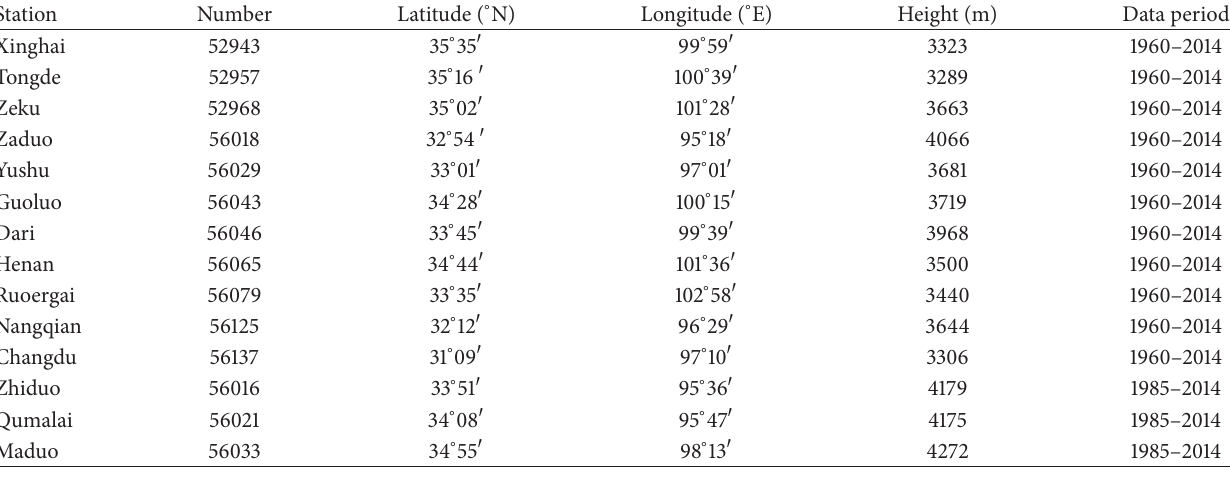
Table 1: Details of the meteorological stations.